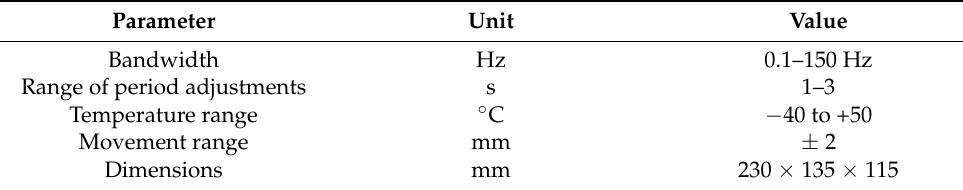
Table 2. Basic parameters of Willmore MK III seismometer